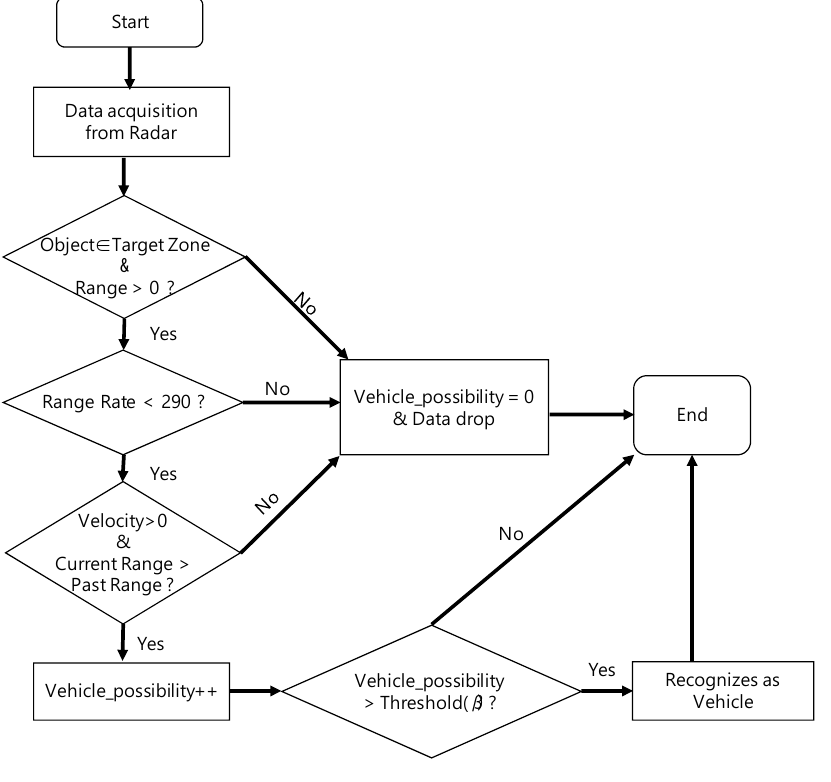
Figure 14. Noise filtering algorithm of the RWM.